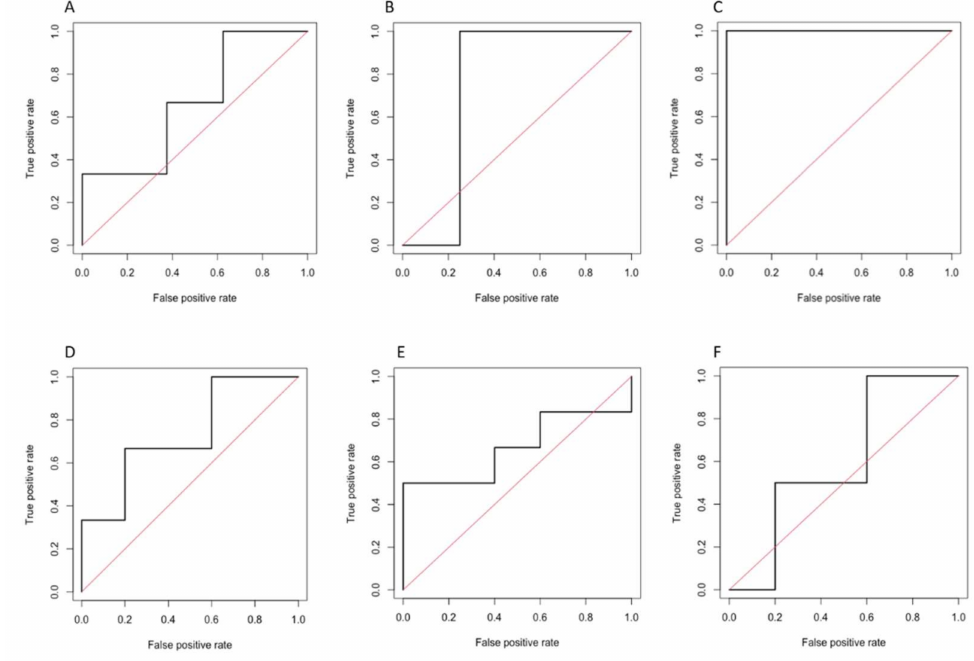
Figure 4. ROC curves of the radiomics model 1 in the test set for predicting complete response on portal-venous ( A ), 3 (cid:48) transitional ( B ), and hepatobiliary ( C ) phases, and for predicting objective response on portal venous ( D ), 3 (cid:48) transitional ( E ), and hepatobiliary ( F ) phases.